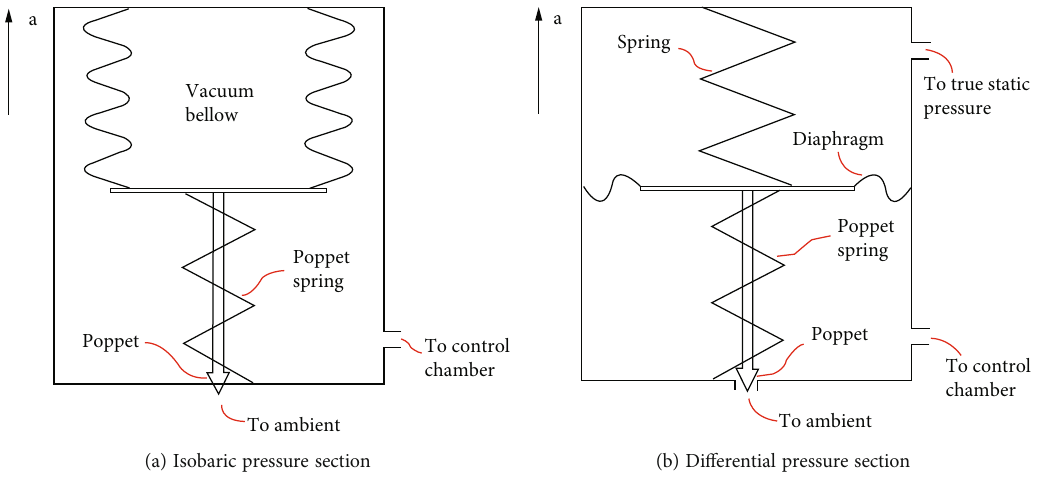
Figure 5: Schematic diagram of the cabin pressure